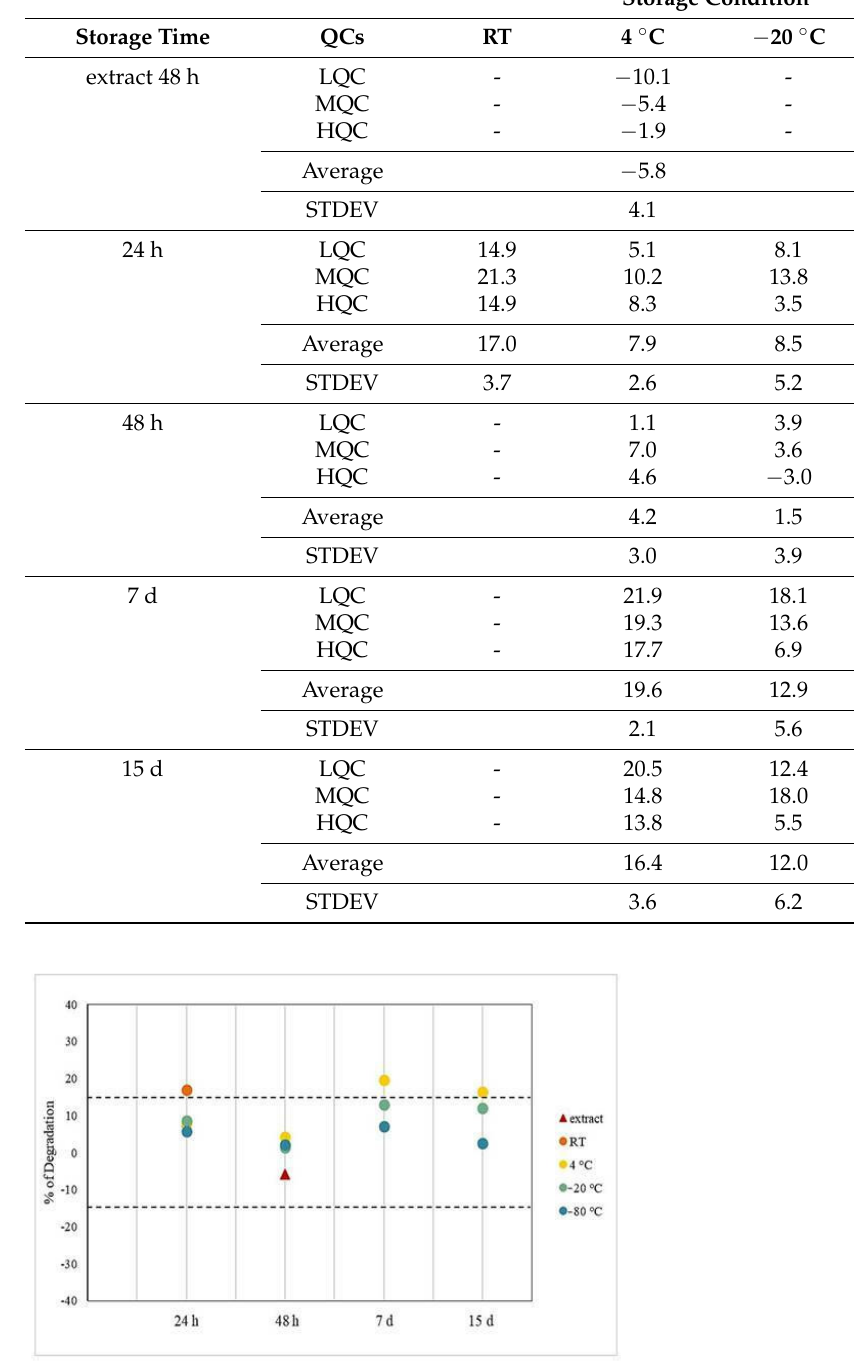
Figure 4. Stability of CNB in extracts and plasma samples at different storage conditions over two weeks, reported as the percentage of molecule degradation. For clarity only the average value reported in Table 3 is here represented. Dashed lines show acceptability range of ±